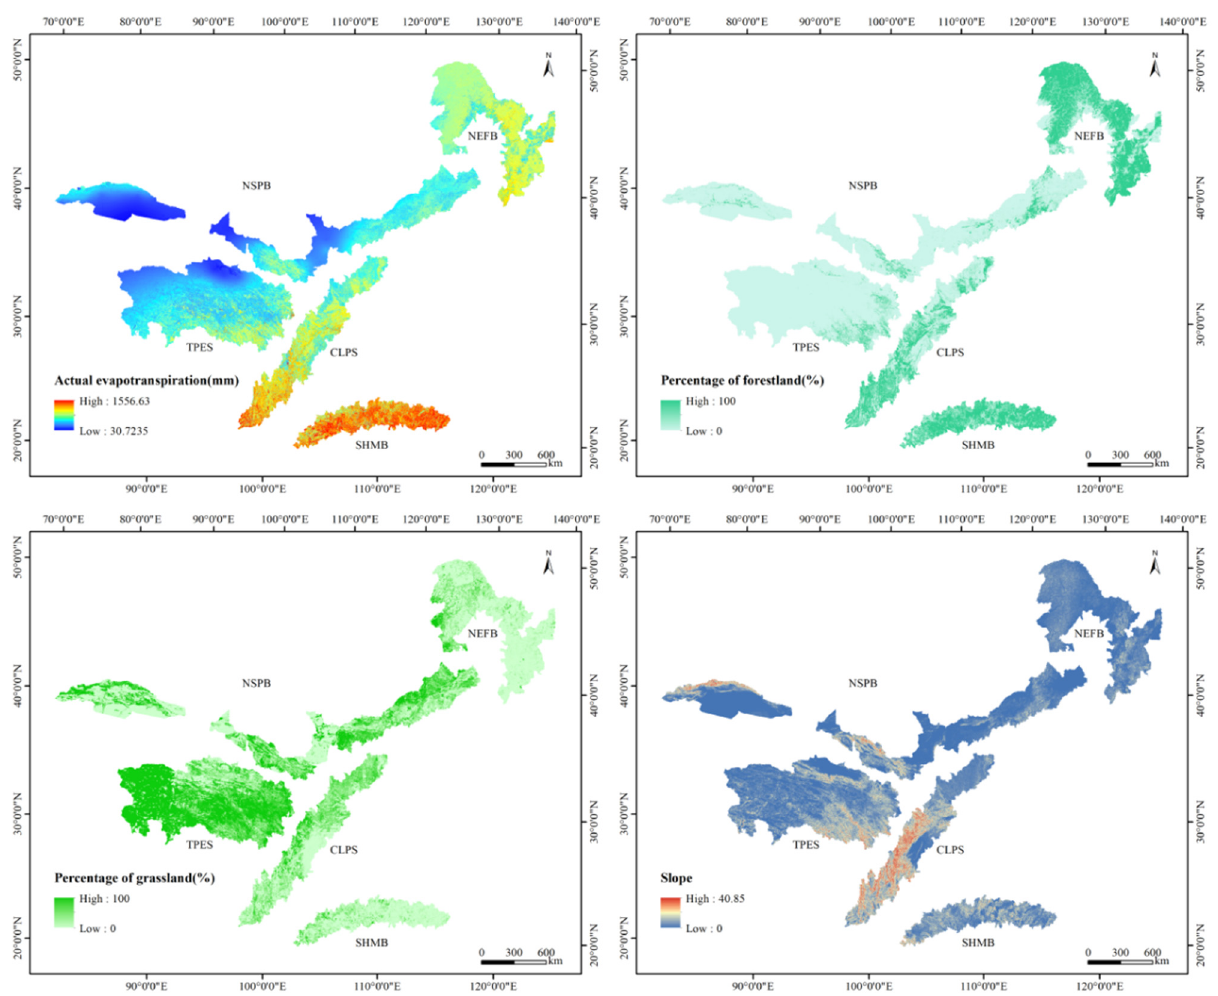
Figure 6. Spatial pattern of actual evapotranspiration, the percentage of forestland and grassland and slope in the TSTB.